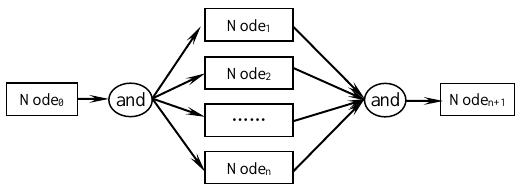
Figure 7. Concurrent process.